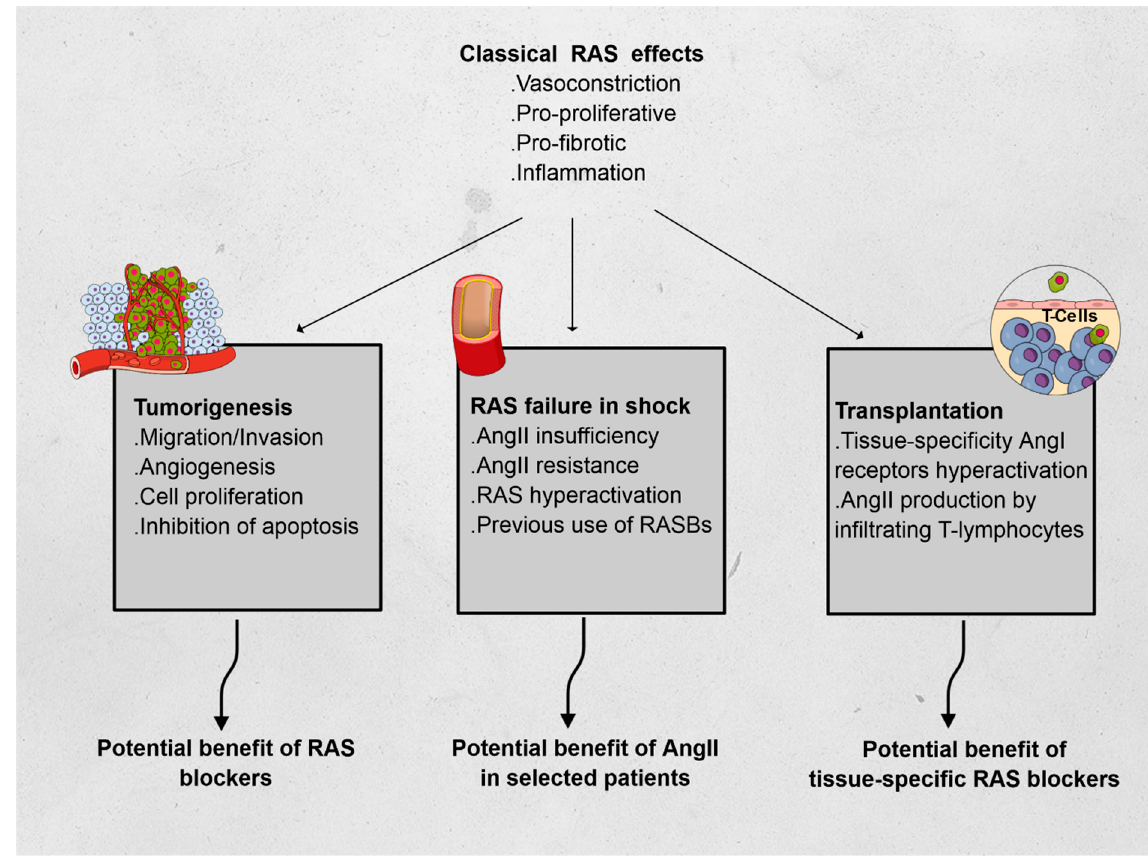
Figure 1. Effects of the renin–angiotensin system (RAS) and its features in oncology, vasoplegic shock, and transplantation. Abbreviations: AngI: angiotensin I, AngII: angiotensin II.